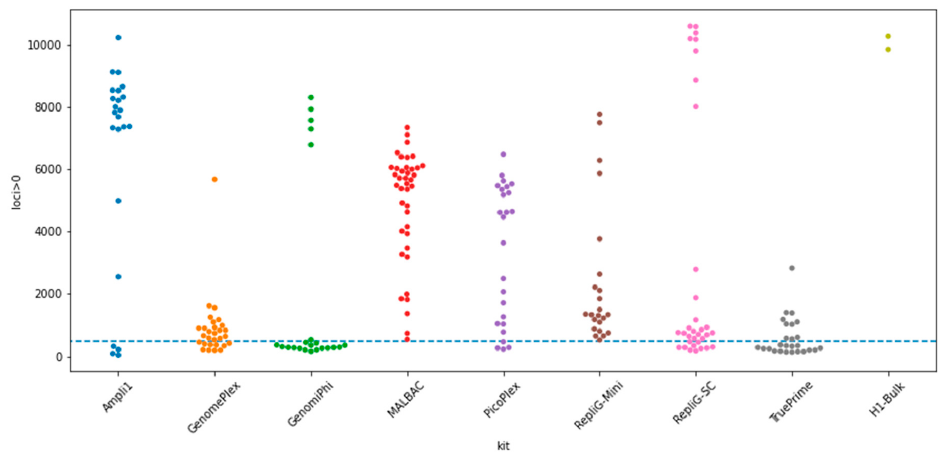
Figure 2. Loci sampled per cell (higher is better)—amplicon coverage per single cell per kit. Each dot represents a single-cell WGA sample, except for the bulk column, where each dot represents a cell bulk duplicate originated from the same cell line (H1). See also Supplementary Materials Figures S1–S4 for additional